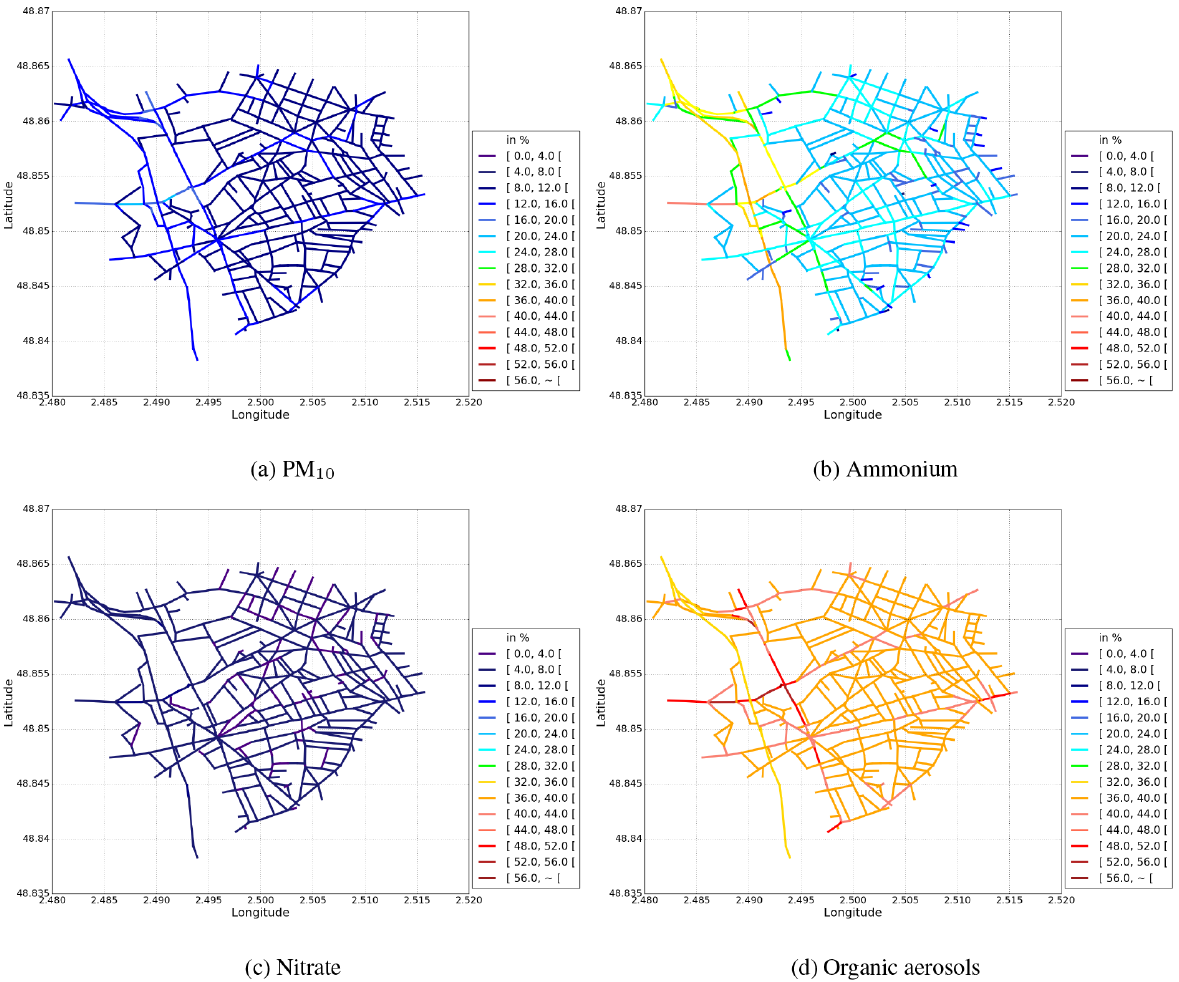
Figure 9. Temporal NME (in %) between Case-1 and Case-2 for (a) PM 10 , (b) ammonium, (c) nitrate, and (d) organic aerosols. The absolute differences in the concentrations between the simulations are presented in additional figures in the Appendix